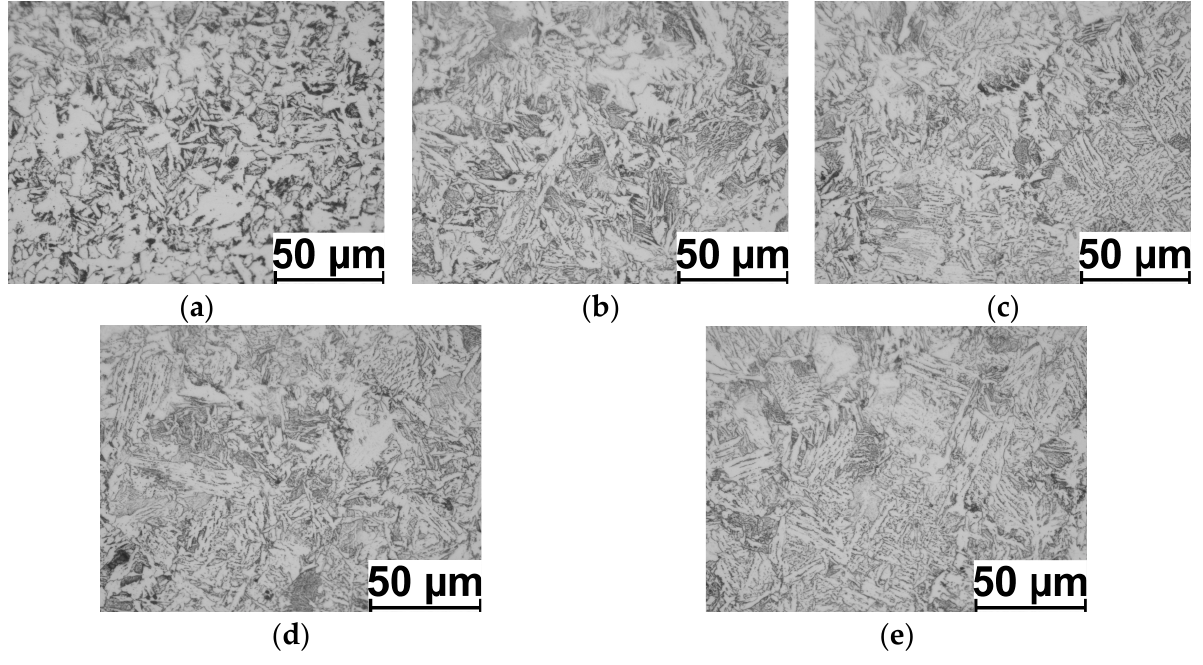
Figure 14. Example microstructures of 20MnB4 steel after physical modelling of a wire rod rolling process for test variant V2 (marking of points in accordance with Figure 5): ( a ) point P. 1, ( b ) point